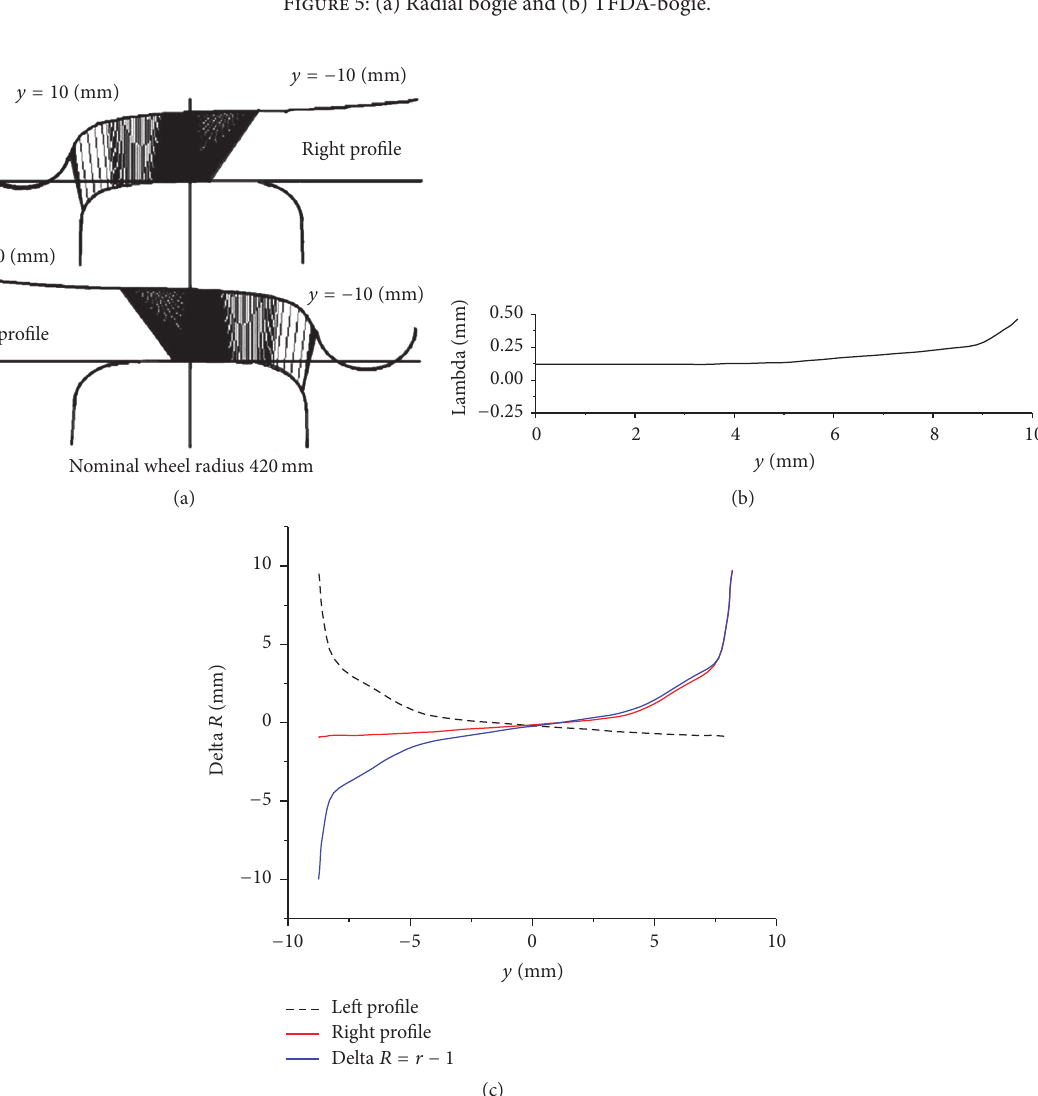
Figure 6: Wheelsets contact geometry: (a) contact connections; (b) equivalent conicity; (c) wheel diameter difference. while the whole vehicle wear power of TFDA-bogies is inferior. Under traction condition, the overall performance of TFDA-bogies is superior to conventional bogies, as traction is an important factor affecting the whole vehicle wear